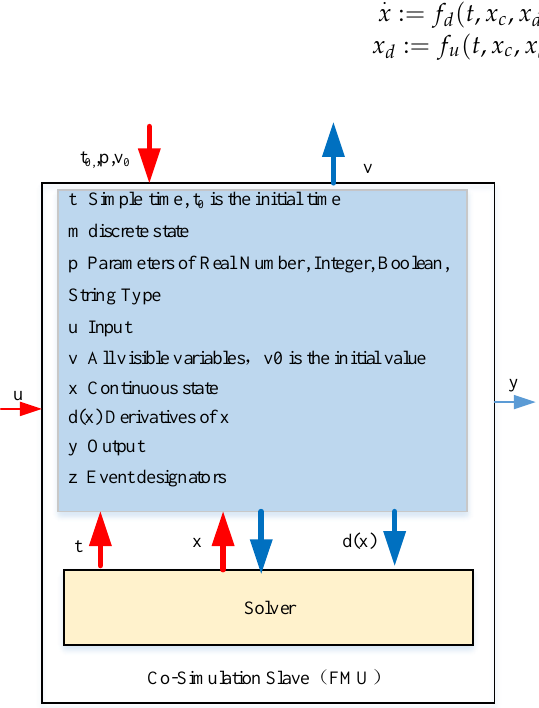
Figure 17. FMU structure and variables [28].